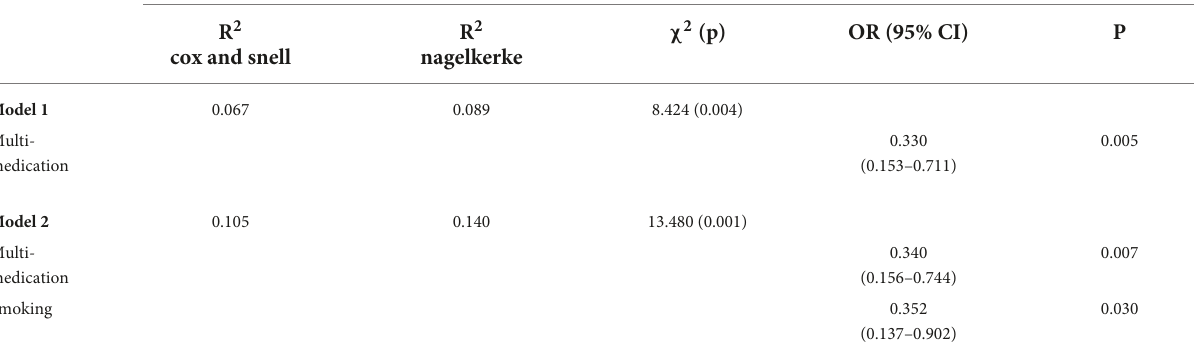
TABLE 3 Logistic binary regression analysis (Dependent variable: SF-36 dichotomic; Predictors: balanced diet, regular exercise, overweight, smoke,